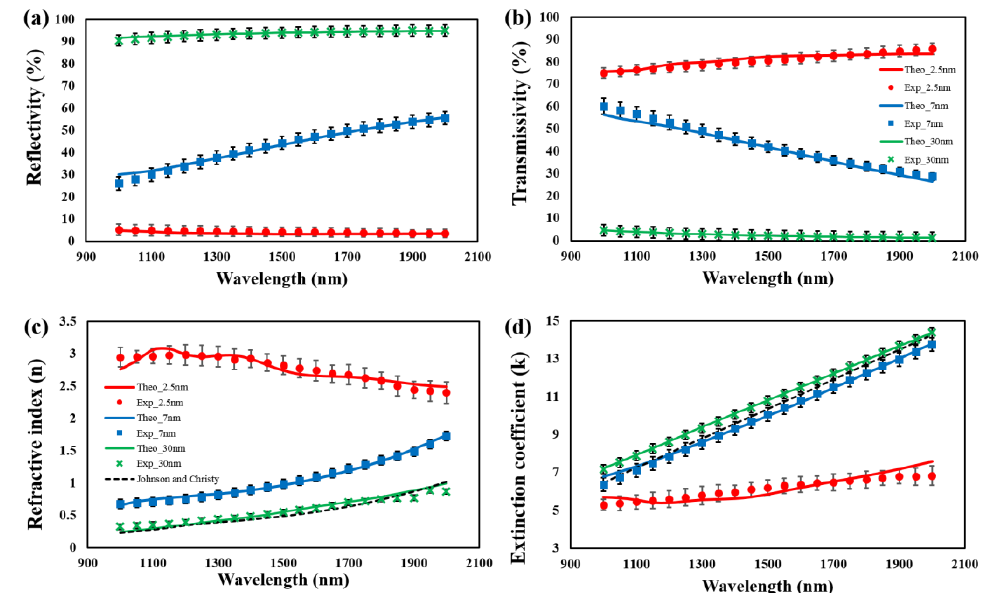
Figure 3. Reflection (a) and transmission (b) with refractive index n (c) and extinction coefficient k (d) for the 2.5 nm, 7 nm, and 30 nm samples. Optical constants of the thin film samples are extracted from RT data. n and k for 7 nm and 30 nm are very similar, and converge to bulk values (dashed line, tabulated data from John and Christy [27] ). The behavior for the 2.5 nm sample is significantly different from those for 7 and 30 nm samples, indicating the impact of quantum size effect. Predictions from our QEM are also plotted, all showing good agreement with the experimental result.